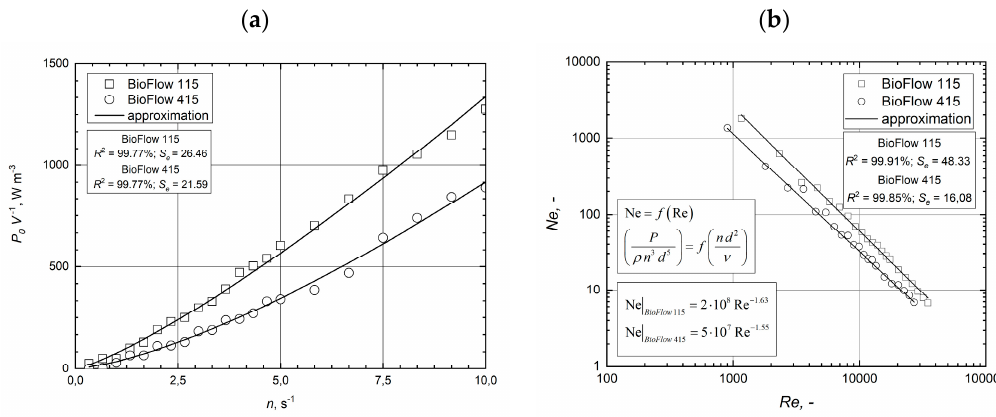
Figure 4. Power consumption per unit volume versus impeller rotational speed ( a ) and power characteristics ( b ) for the tested bioreactors.